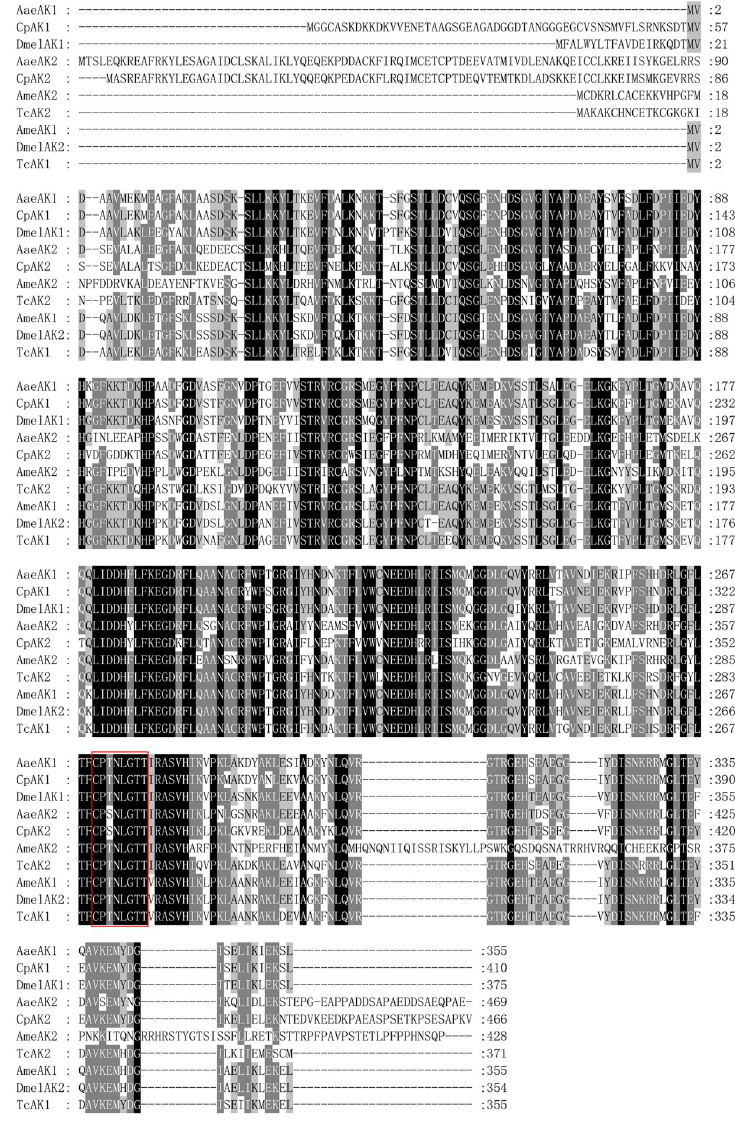
Fig 1. Comparison of amino acid sequences of CpAK1 and CpAK2 with other insects including Aedes aegypti ( AaeAK1 , AaeAK2 ), Drosophila melanogaster ( DmelAK1 , DmelAK2 ), Apis mellifera ( AmeAK1 , AmeAK2 ), Tribolium castanuem ( TcAK1 , TcAK2